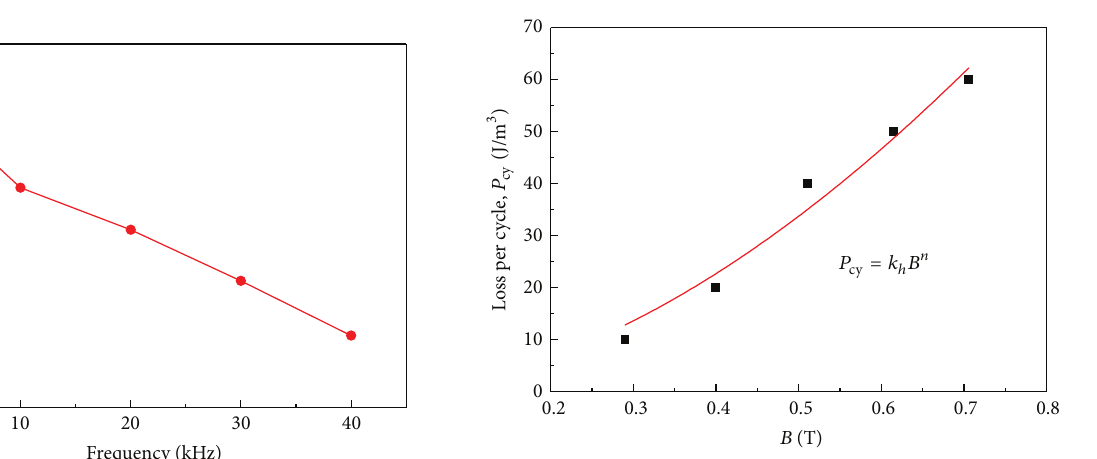
-frequency curves at cy are plotted in Figure 10. exc